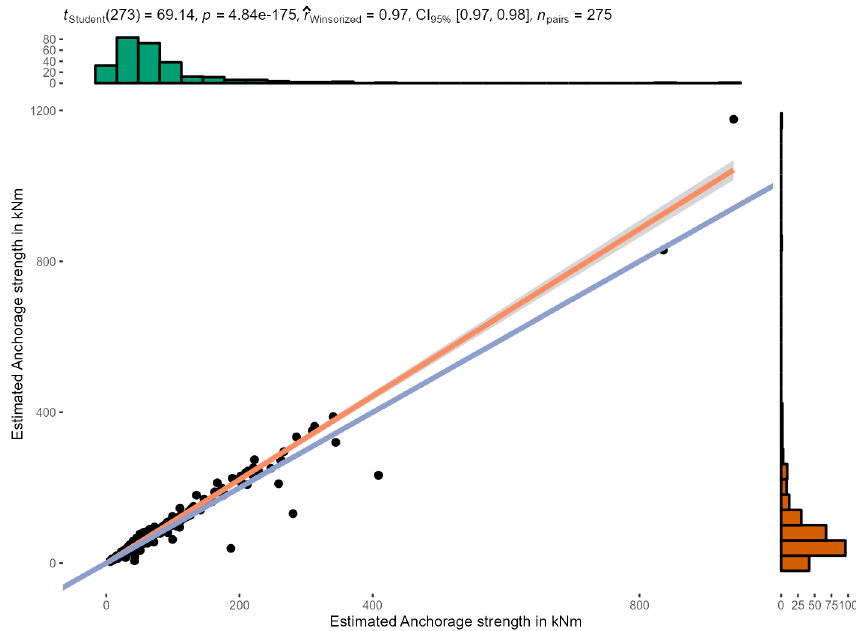
Figure 7. Comparison of estimates from Equation (1) (x-axis) and Equation (3) (y-axis) with four outliers removed. The blue line illustrates 1:1.